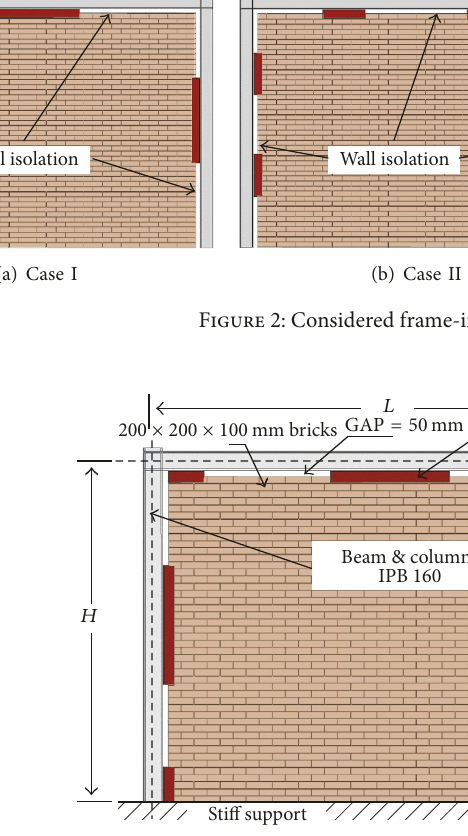
Figure 3: Sample geometrical configuration of Case I.